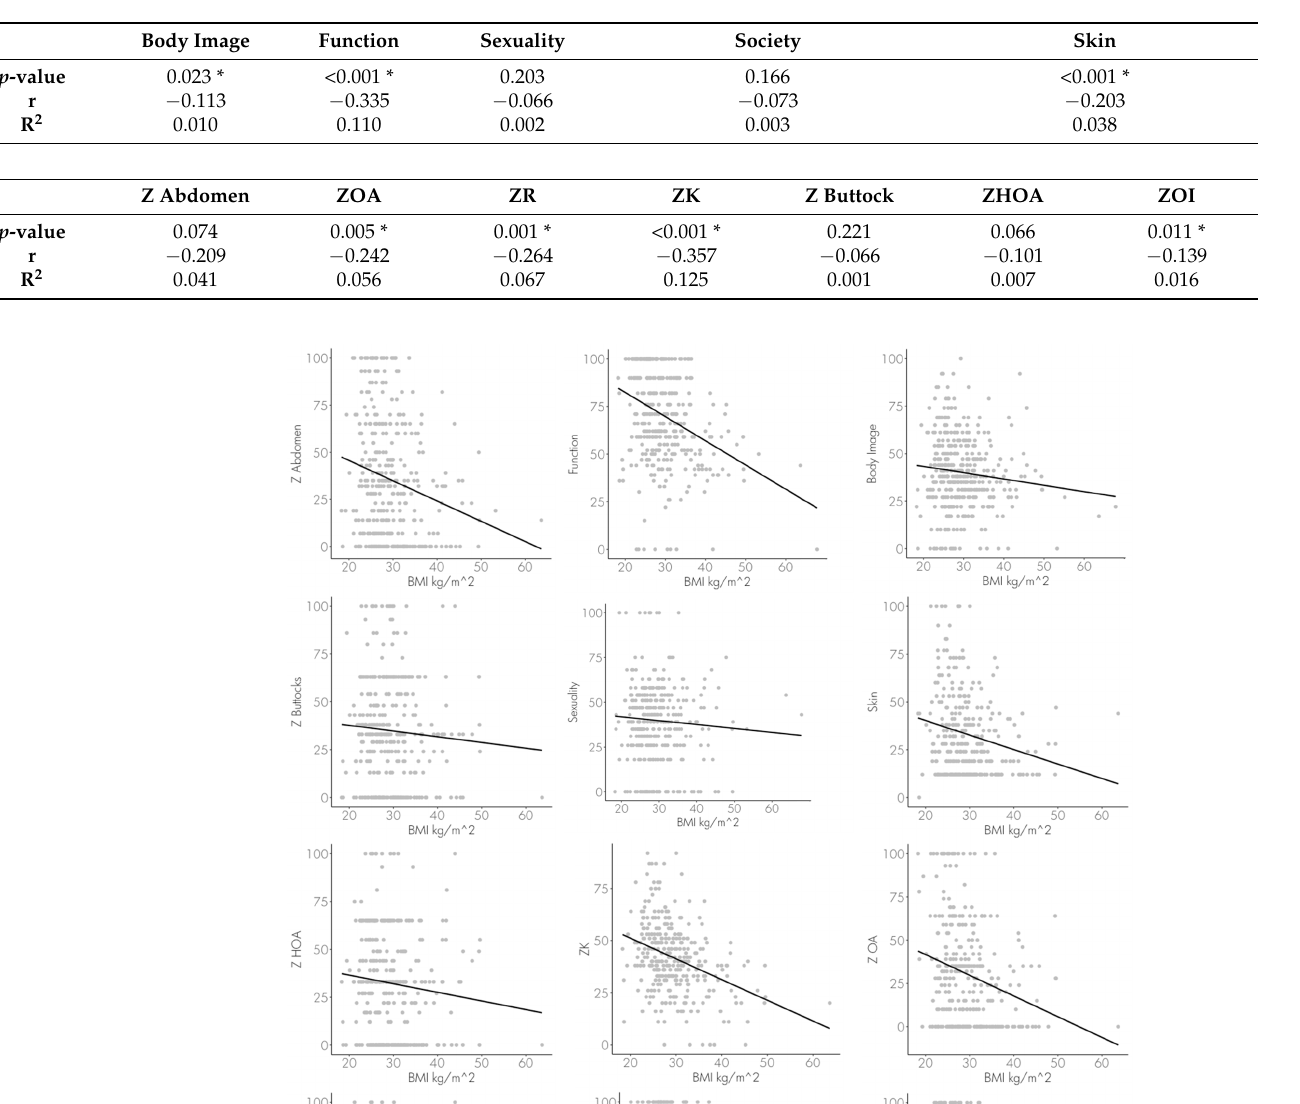
Table 3. Presentation of the correlation coefficients according to Pearson (r) for the categories body image, function, sexuality, society, skin, satisfaction-stomach (ZAbdomen), satisfaction-upper arms (ZOA), satisfaction-back (ZR), satisfaction-body (ZK), satisfaction-buttocks (ZButtocks), satisfaction- hips and outer thighs (ZHOA), satisfaction-inner thighs (ZOI), of the BODY-Q questionnaire and the patients’ BMI; the p -values; the coefficient of determination (R 2 ); * A correlation level of 0.05 was assumed to be significant.